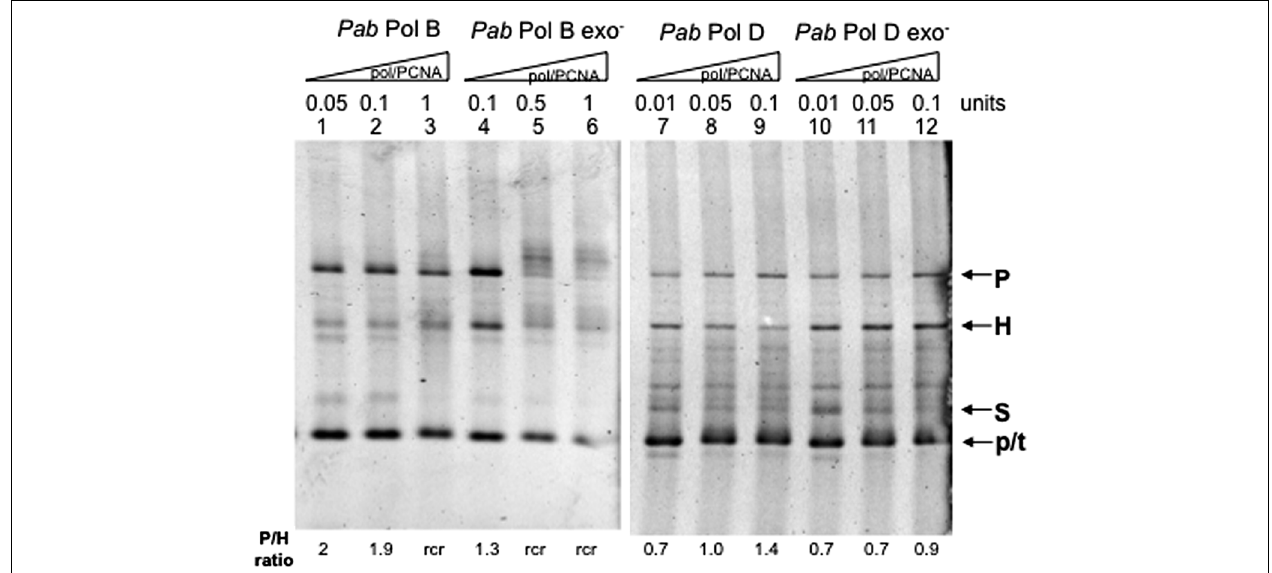
FIGURE 5 | Effect of PabPCNA on Pab DNA polymerase slippage. Primer extension reactions were carried out as described in the “Materials and Methods” on 25 ng (12.2 fmol)of FXc template using increasing amounts of Pab DNA polymerase and equimolar amounts of PabPCNA. One polymerase unit represents 27 pmol Pab PolB: 4 pmol Pab PolB